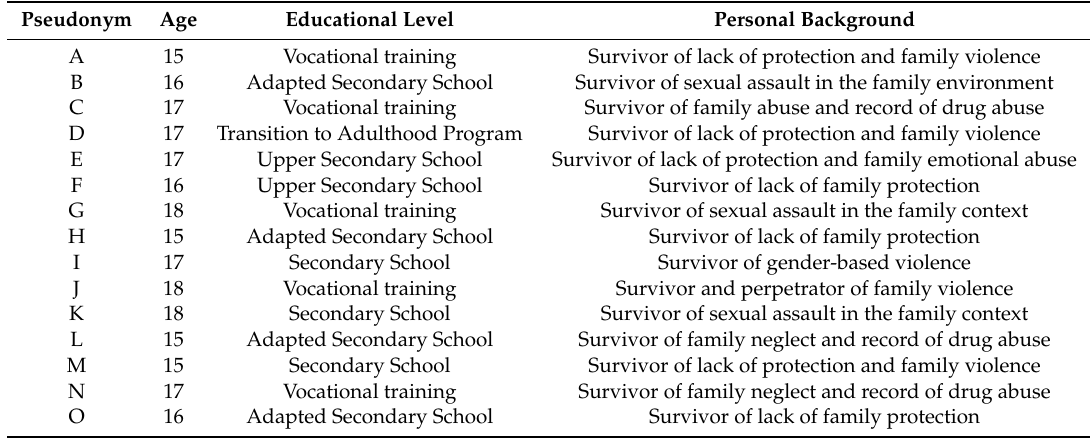
Table 1. Profiles of research